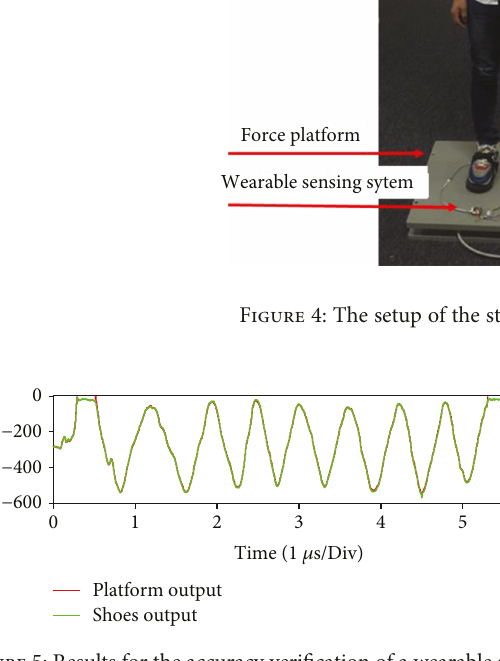
Figure 5: Results for the accuracy veri fi cation of a wearable sensing